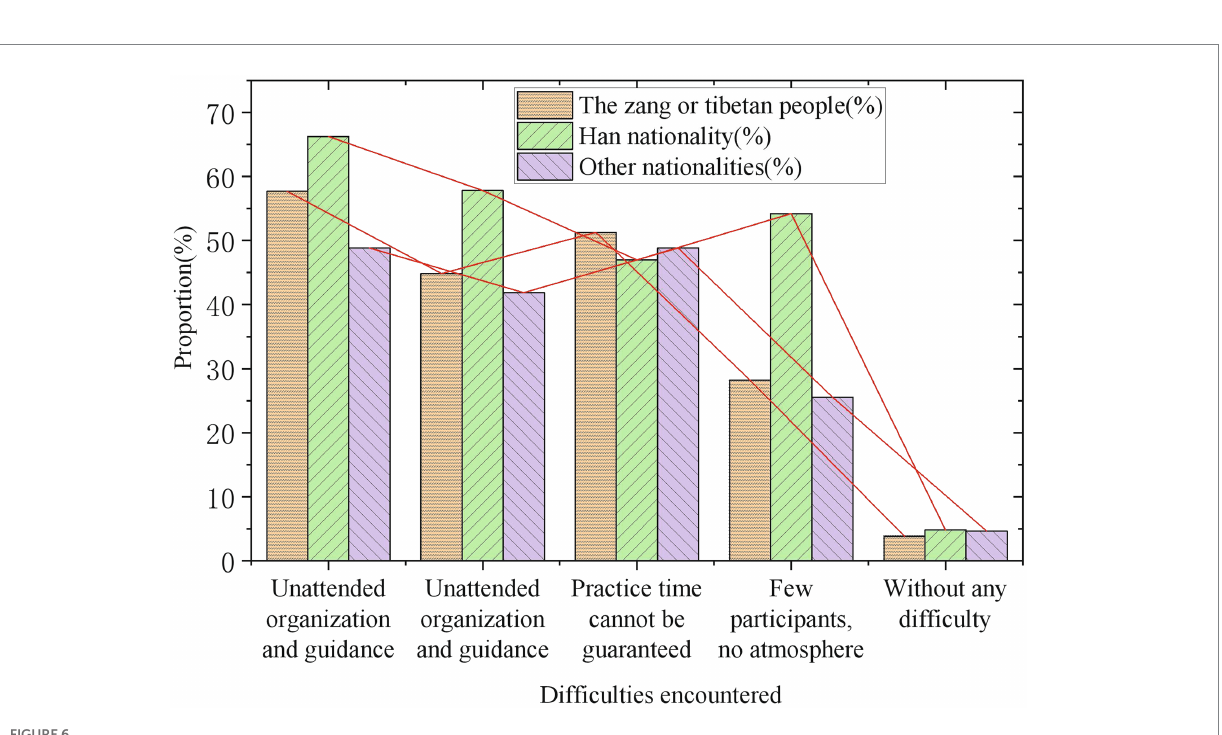
FIGURE 6 The development status of Guozhuang dance in universities (by